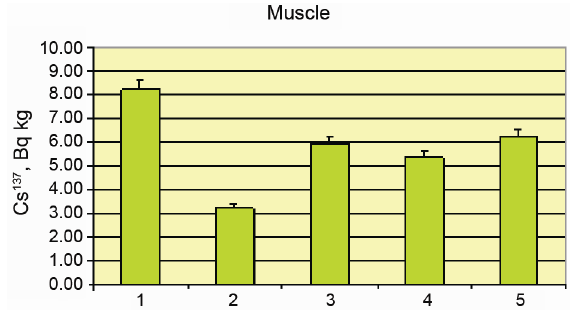
137 Cs in fox muscle: